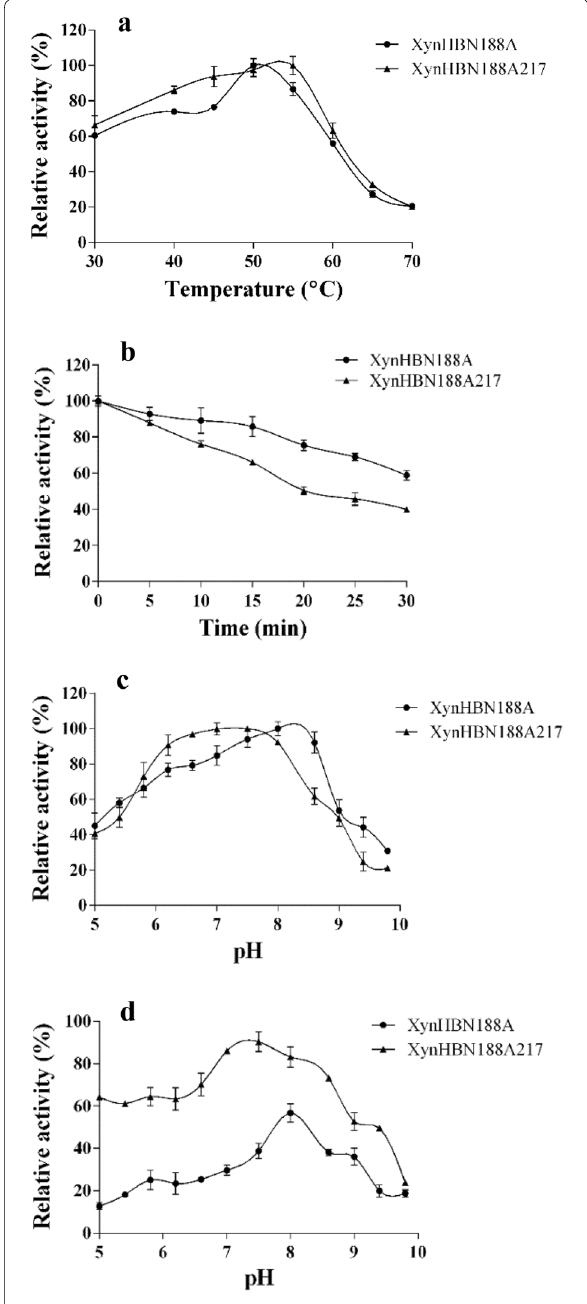
Fig. 2 Effects of temperature and pH on activity ( a , c ) and stability ( b , d ) of XynHBN188A217. Beechwood xylan (1%) was used as substrate for xylanases activity assay. The highest activity was taken as 100% in assay of optimum temperature and pH. The xylanase activity under optimal conditions was taken as 100% in thermostability and pH stability assays. The thermostability was tested by pre-incubation the enzyme at 60 °C. The pH stability was tested by diluting the purified enzyme with the different pH buffer and incubating at 4 °C for 12 h. Then the residual activity was measured at the optimal